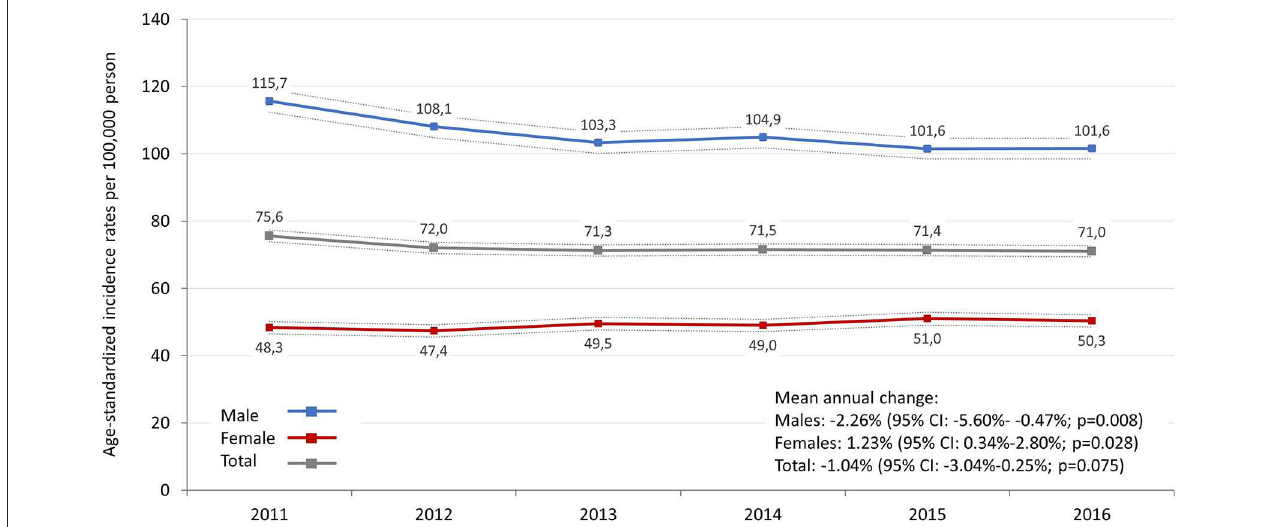
FIGURE 1 | Age-standardized incidence rates (standard: ESP 2013) of lung cancer by sex in Hungary between 2011 and 2016 (per 100,000 person-years; dotted lines represent 95% CI). CI, confidence